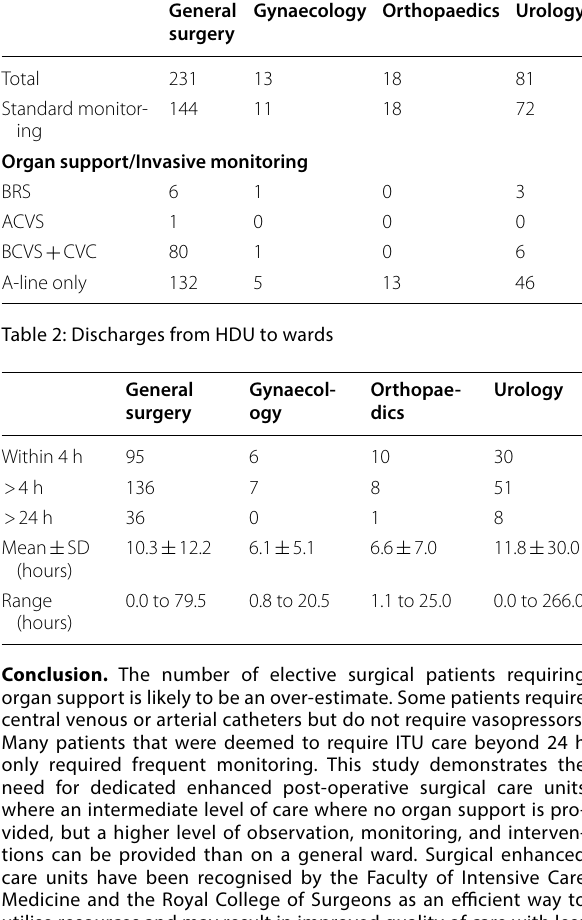
Table 1: Care received according to surgical group General Gynaecology Orthopaedics Urology surgery